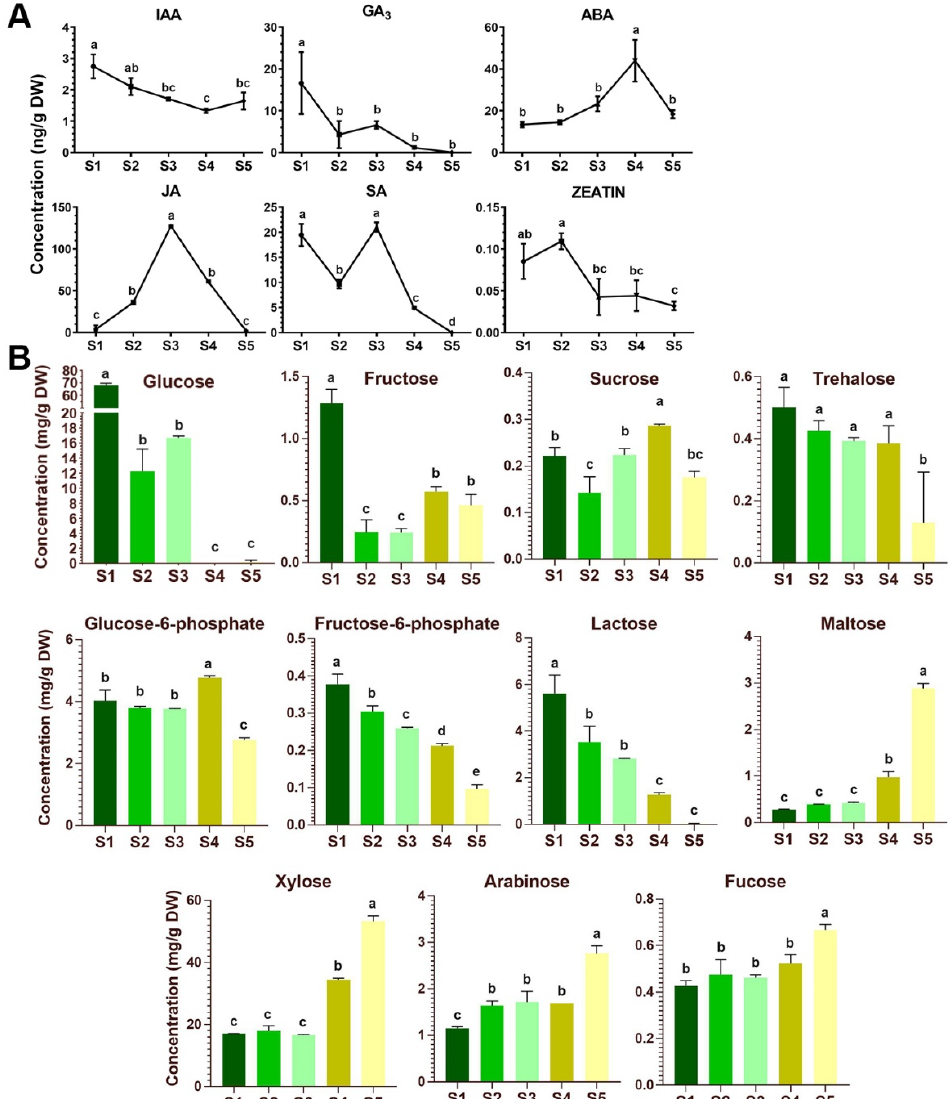
Figure 5. Phytohormone and sugar contents in the 5 stages during P. axillaris flower development. ( A ) Phytohormone dynamics during the flower development. Data are mean and SD of three independent experiments. ( B ) Sugar contents in the developmental stages. Date represent mean and SD of three independent experiments. Significant difference between group with variable letters above the line or bar are verified using two-way ANOVA and multiple T -test ( p < 0.05) implemented in the Prism software version 7.04.